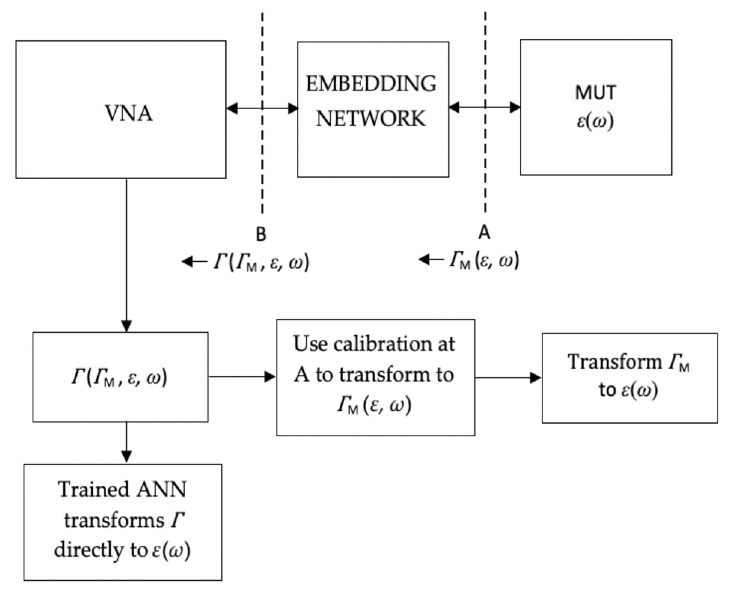
Figure 2. A schematic of a typical dielectric measurement setup, showing the measurement and transformation process to obtain the permittivity of the MUT. Also shown is the proposed ANN technique, requiring only calibration at the VNA test port (reference plane B in Figure 1). Γ M and Γ are respectively the reflection coefficients at the probe-material interface (reference plane A) and the VNA test port (reference plane B)